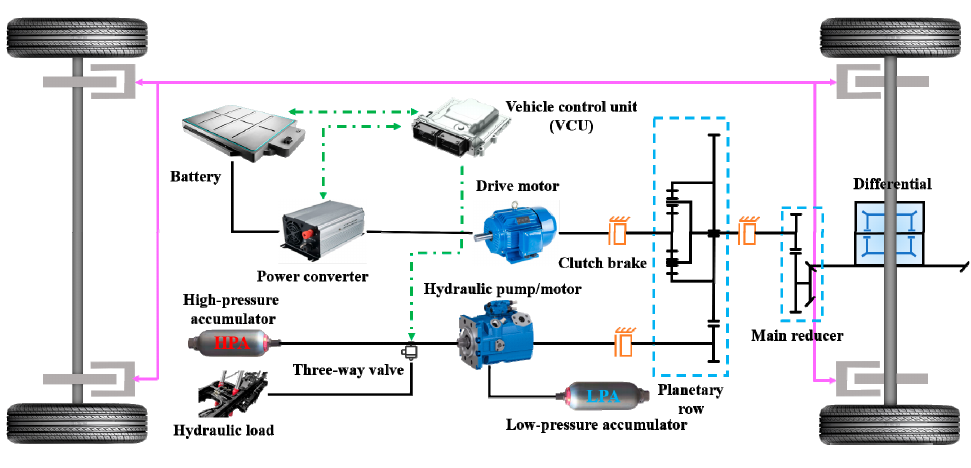
Figure 1. The structure of the MSEH-HEV.